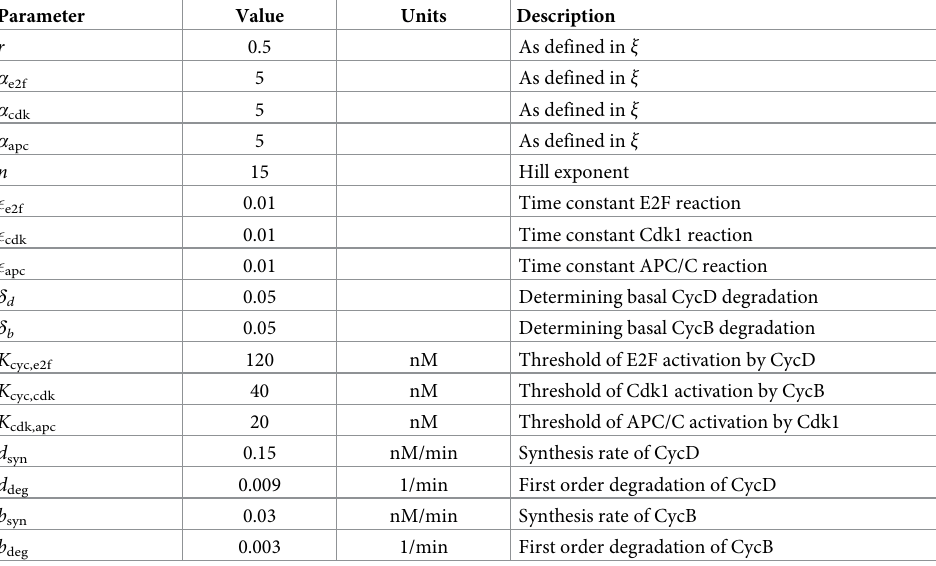
Table 2. Default parameter values for modeling the cell cycle as interlinked bistable switches.